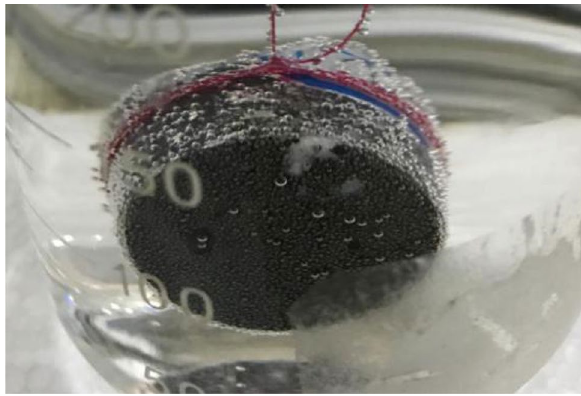
Table 5 Imbibition capacity index with different KCl concentrations KCl, % 2 C t , × 10 −5 m/h